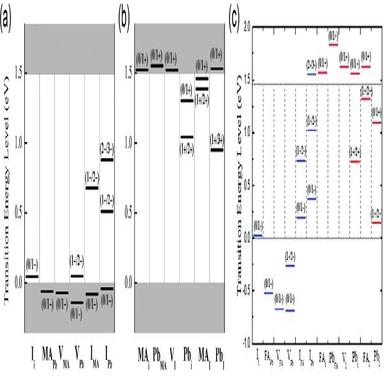
(a and b) The transition energy levels of intrinsic defects in MAPbI3 . Copyright 2014, AIP Publishing LLC. (c) The transition energy levels of intrinsic defects in FAPbI3. Copyright 2018, Royal Society of Chemistry.